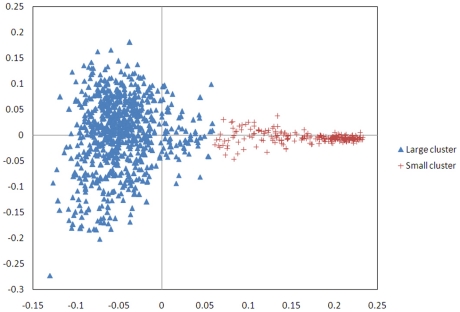
Multidimensional scaling (MDS) analysis of an Identity by State (IBS) matrix of 986 samples, divided into two clusters which reflect differing proportions of Holstein and Friesian ancestry.Both phenotypes and genotypes were adjusted for the population structure before analysis.